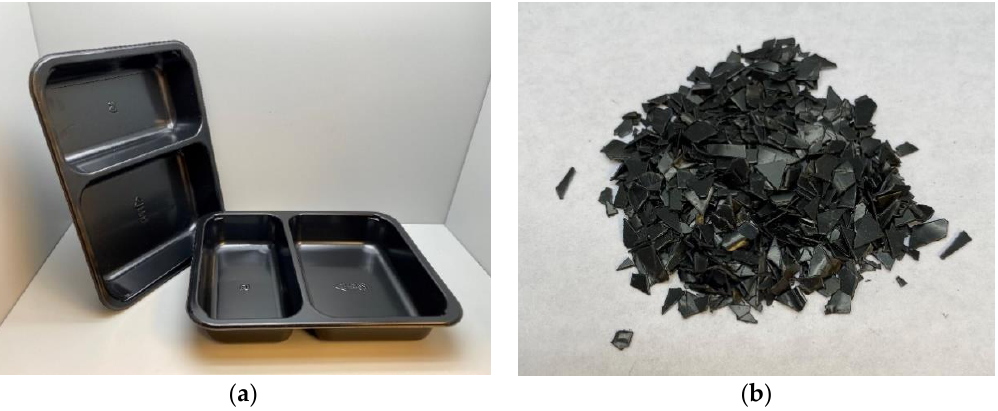
Polymers 2022 , 14 , x FOR PEER REVIEW Figure 1. CPET ( a ) trays and ( b ) flakes used in CPET/biofiller blends. Figure 1. CPET ( a ) trays and ( b ) flakes used in CPET/biofiller blends.